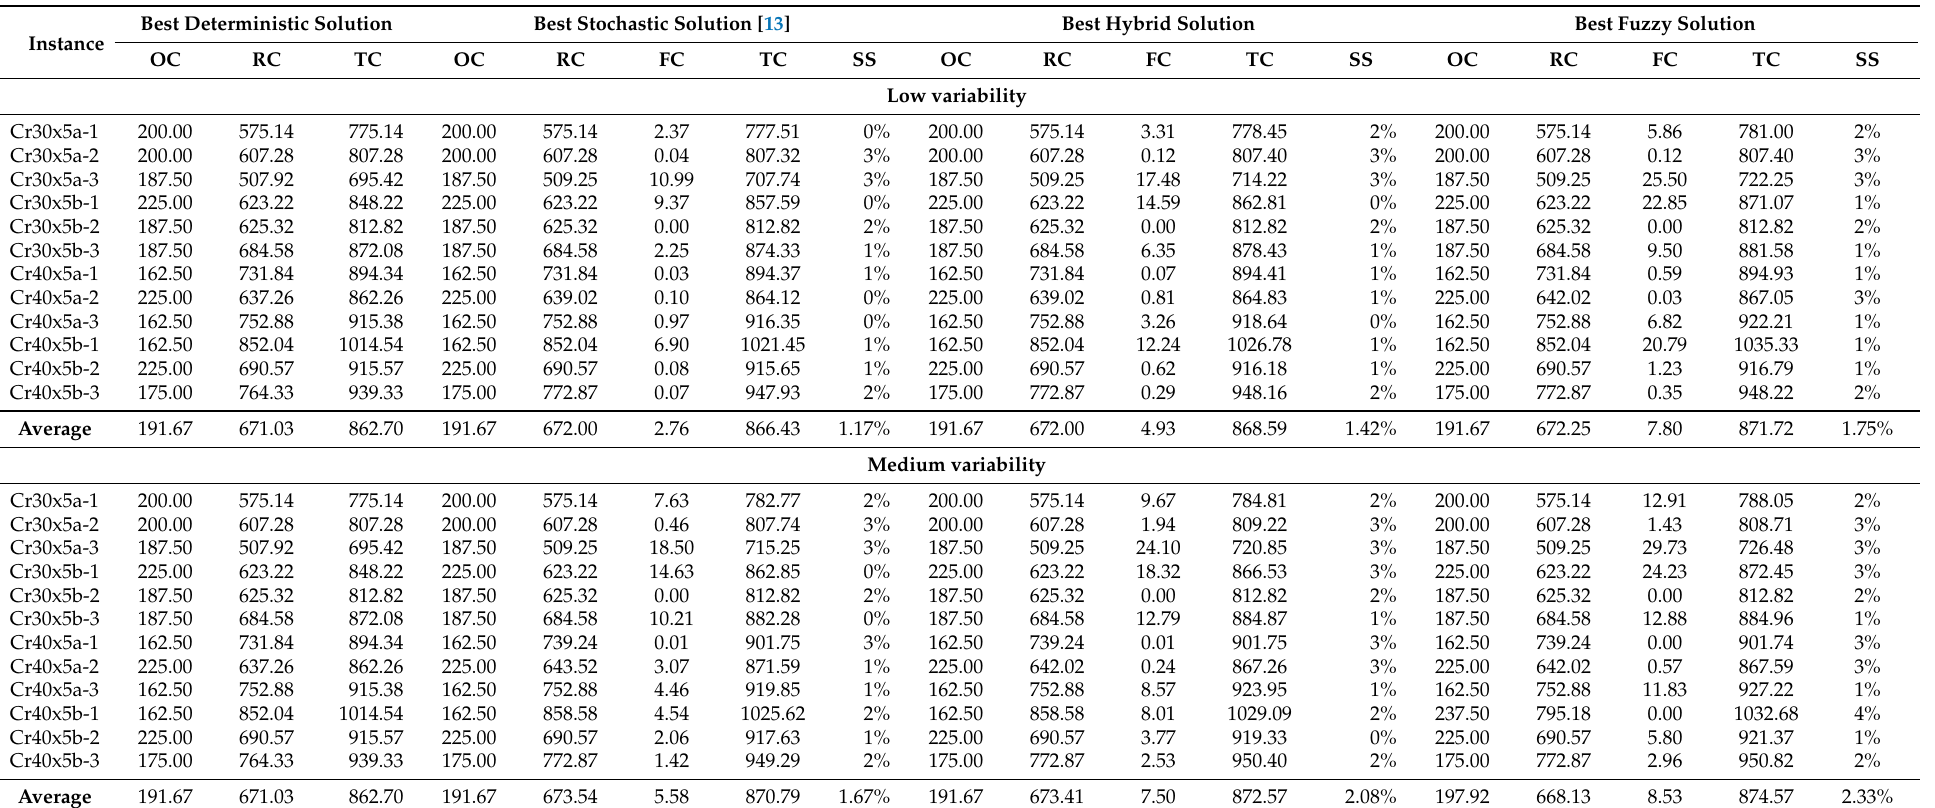
Table 3. Comparative results between our flexible solutions under different uncertainty